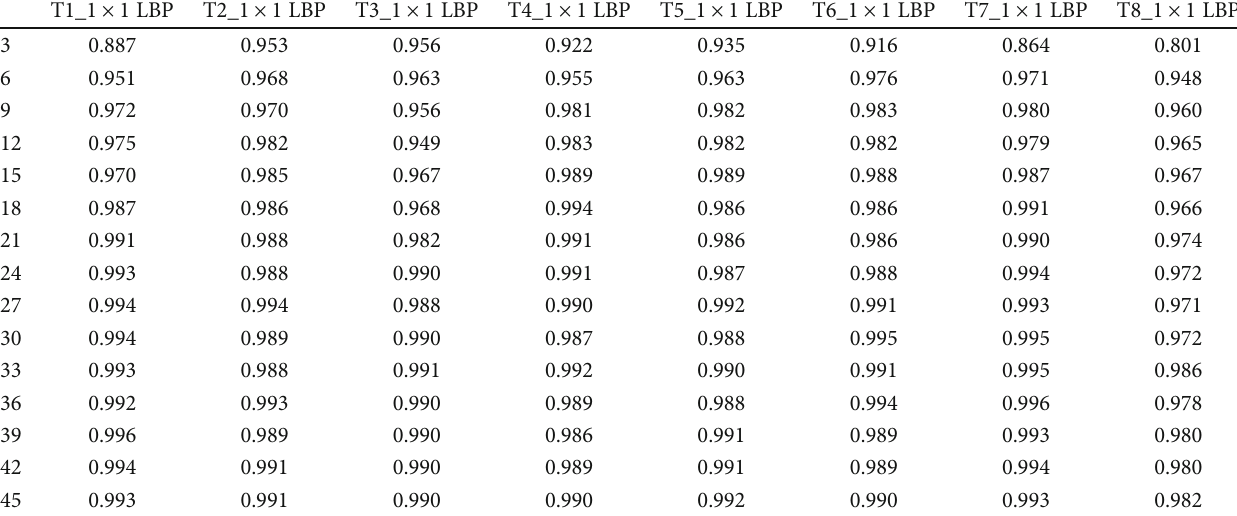
Table 7: Average classi fi cation accuracy of 8 fusion features with di ff erent dimensions in the 5 times 10-fold cross